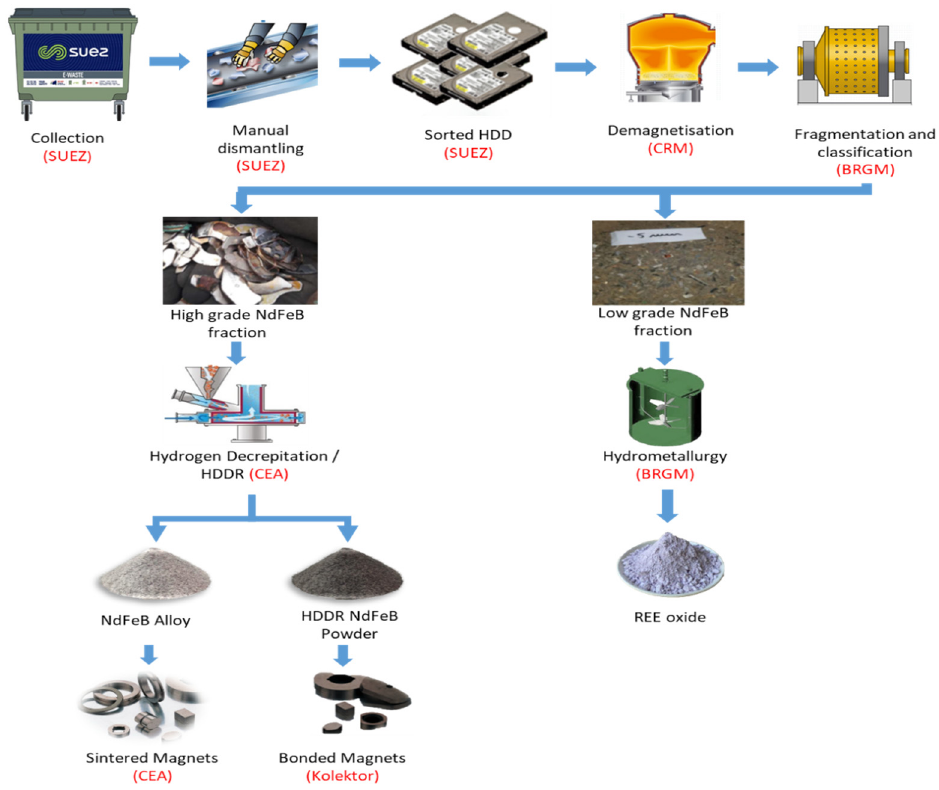
Figure 1. Process flow chart planed in VALOMAG initiative, with the involved partners in red.